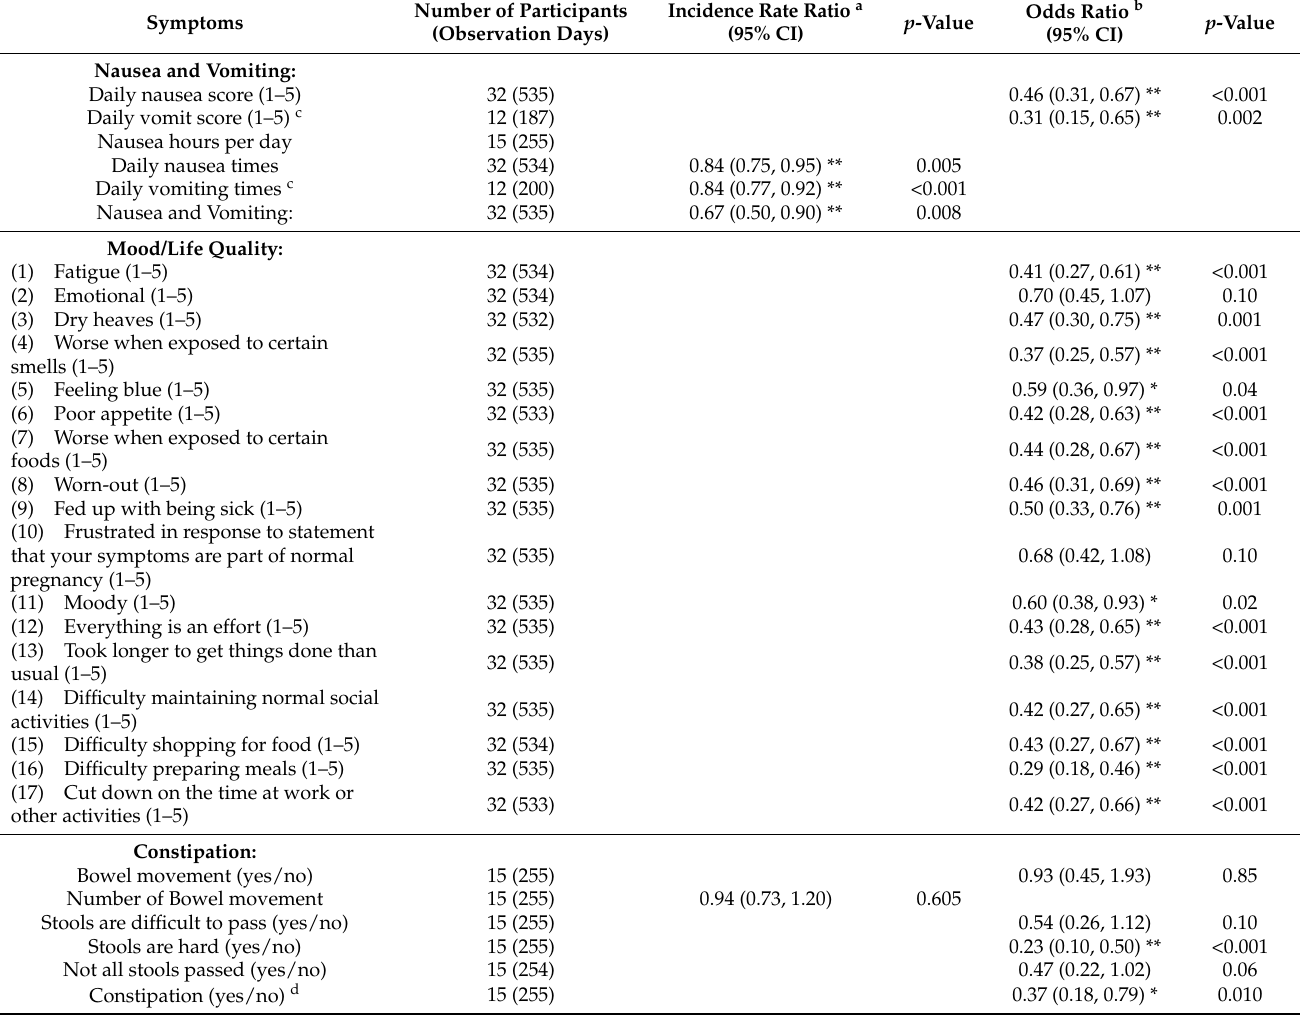
Table 2. Estimated ITT effects of probiotics based on generalized linear mixed-effects models adjusted by gestational